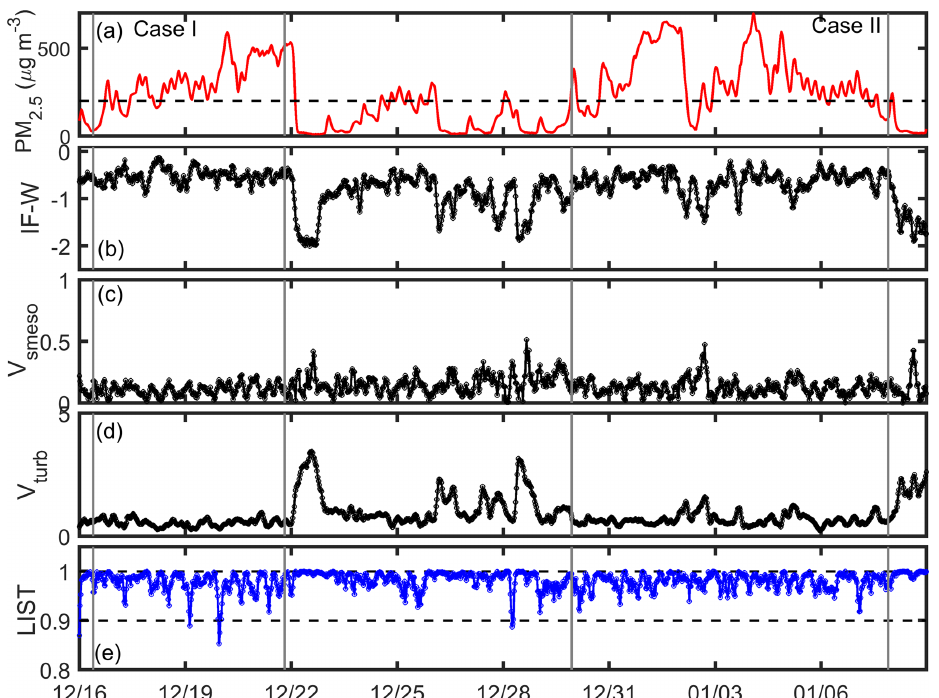
Figure 8. Time series of the (a) PM 2 . 5 concentrations, (b) intermittency factor (IF) of vertical velocity, (c) velocity scale of submesoscale motions ( V smeso ), (d) velocity scale of turbulence ( V turb ), and (e) LIST from 16 December 2016 to 8 January 2017 at the city